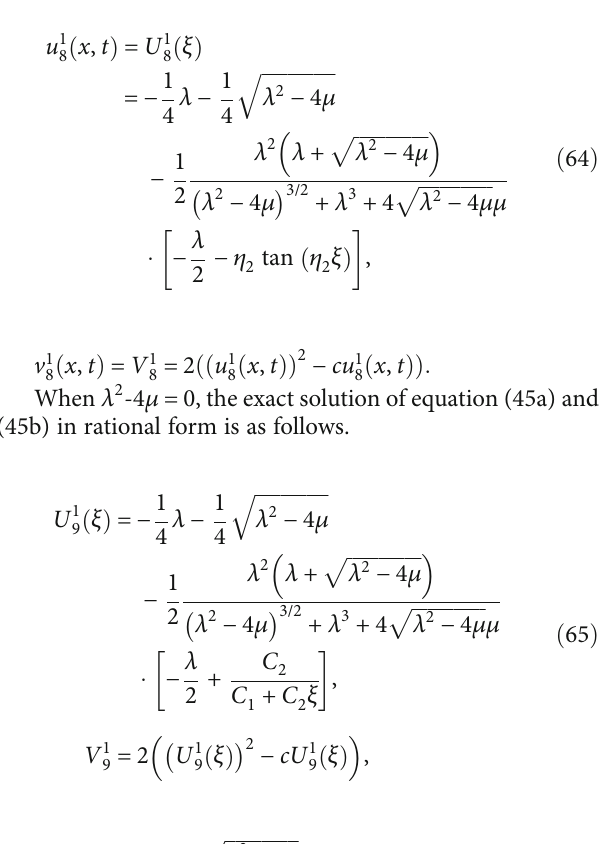
ffiffiffiffiffiffiffiffiffiffiffiffiffiffiffi p λ 2 − 4 μ